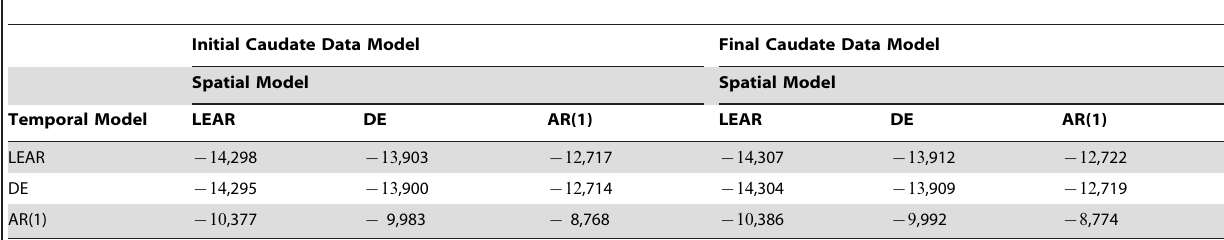
Table 3. AIC values for all combinations of factor specific correlation models.